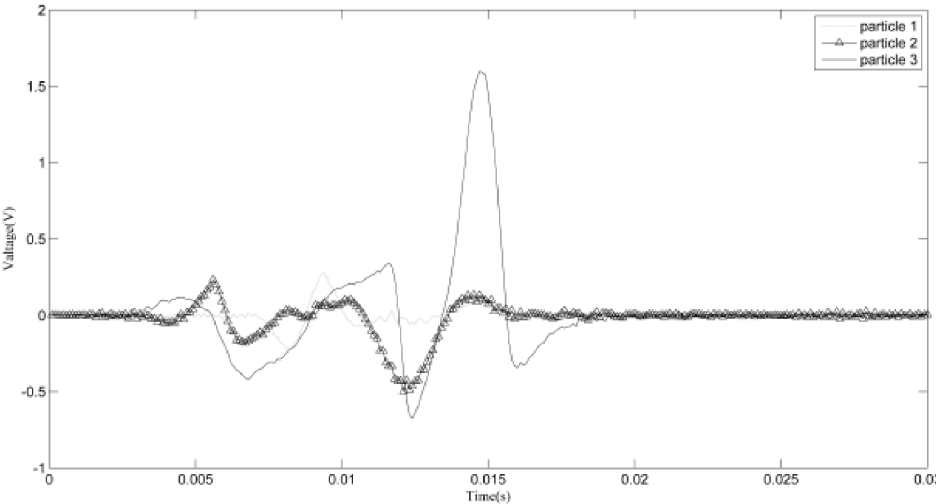
Figure 13. Demixing result of section a2 into three particles.